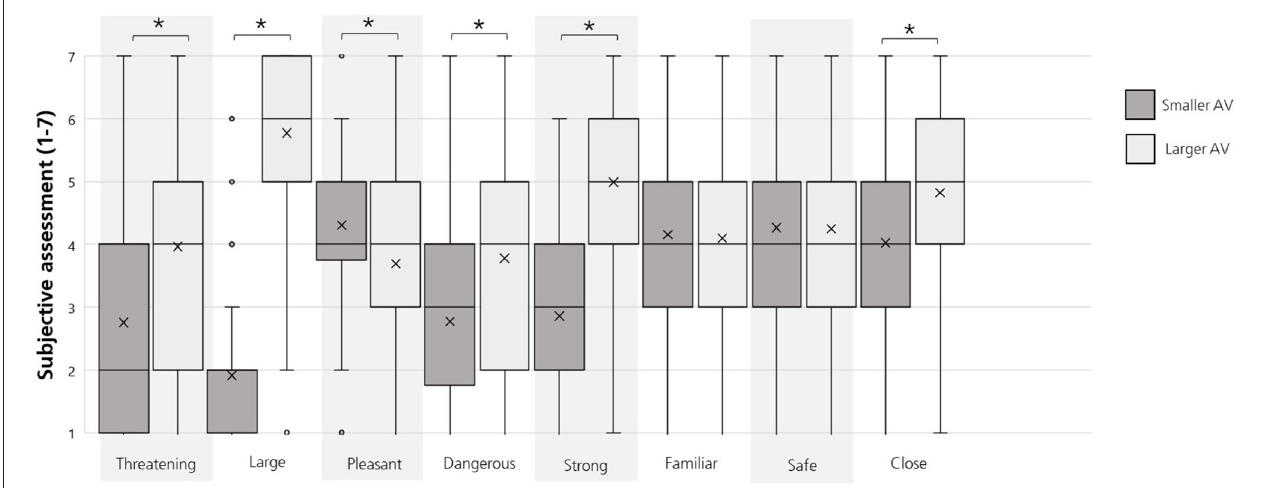
FIGURE 3 | Boxplots for participants’ subjective assessments on each vehicle’s (smaller AV vs. larger AV) characteristics for their interactions in the videos. Note . Crosses = means; lines = medians. Bonferroni-corrected p- value * < 0.003.